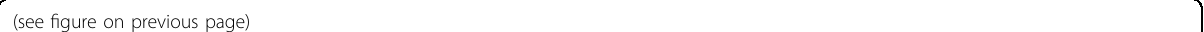
Fig. 3 Glucocorticoid treatment qualitatively improves the erythroid-primed C4 subpopulation by reducing apoptosis. a t-SNE visualization of aggregated cells (Aggregated), cells from the normal controls (NC, red) and cells from the individual DBA groups (UT, dark blue; GCR, green; GCNR, purple). b Bar plot showing the ratio of observed to expected numbers of cells (Ro/e) in each cluster of each group (NC, red; UT, dark blue; GCR, green; GCNR, purple). The colored dots indicate the individual patients and dot size represents log 10 transformed P values (Chi-square test). Error bars represent the SEM. c Heatmap (left) showing the differentially expressed genes during C4 in the UT, GCR and GCNR groups compared with the NC counterparts. Upregulated genes, downregulated genes and genes without signi fi cant changes are indicated in red, blue and yellow, respectively. The right panel shows the enriched GO terms between NC and UT or GCNR. d Beeswarm plots depict the expression of the gene set of apoptosis. The controls and patients in each group are presented and have been individually color-coded. e Dot plots of representative apoptosis-associated genes across groups. The scaled expression value (Scaled.Exp) and percentage of expressing cells (Per.Exp) from each group are depicted. f Expression of the entire gene set of the P53 signaling pathway. g Dot plots of representative genes in the P53 signaling pathway across groups. The scaled expression value and percentage of expressing cells from each group are depicted. h Schematic illustrating the two-phase erythroid differentiation culture and lentiviral shRNA vector (containing a GFP expression cassette) infection of cord blood CD34 + HSPCs. Four days after initiation of the 2nd differentiation phase, GFP + cells were sorted for further analyses. i The level of RPS19 mRNA detected using RT-qPCR in GFP + cells infected with scrambled control (Scr) or RPS19 shRNA lentivirus (sh1 or sh2). ACTB serves as the internal control. j The upper panel shows RPS19 protein expression detected using Western blot in GFP + cells infected with scrambled control (Scr) or RPS19 shRNA lentivirus (sh1 or sh2). α -tubulin serves as the loading control. The bottom panel indicates the corresponding quanti fi cation of RPS19 protein expression. k Bar graph showing the apoptotic level (measured by the percentage Annexin V + 7-AAD − cells) in RPS19-depleted erythroid cells cultured with or without Dex, which was normalized to the scramble (Scr) control. l The expression of the entire gene set of erythroid differentiation across groups. m Dot plots of representative genes related to erythroid differentiation across groups. The scaled expression value and percentage of expressing cells from each group are depicted. For the bar graphs ( i , j , k ), results are presented as the mean ± SEM. P values were determined by Student ’ s t test. *** P < 0.001, ** P < 0.01 and * P < 0.05; ns, no signi fi cance. n ≥ 3 independent experiments. For all the beeswarm plots ( d , f , and l ), the controls and patients in each group are presented and color-coded individually. Each dot represents the expression value for each single cell that was calculated by summing the log 2 transformed UMI of every gene within the gene set. Diamonds represent mean expression values for each cluster, and boxes represent the median and quartiles. P values were determined by Wilcoxon rank sum test. **** P ≤ 0.0001 and *** P ≤ 0.001, ns, no signi fi cance. See also Supplementary Figs. S3, 4 and Supplementary Table